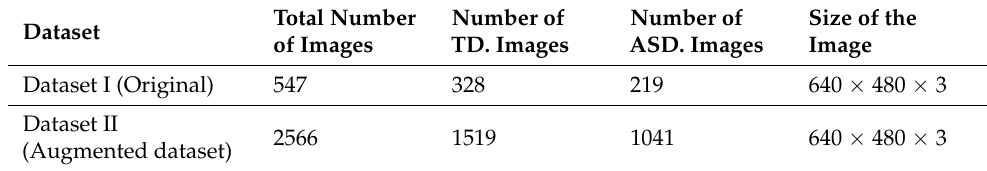
Table 2. Details of the datasets used in our